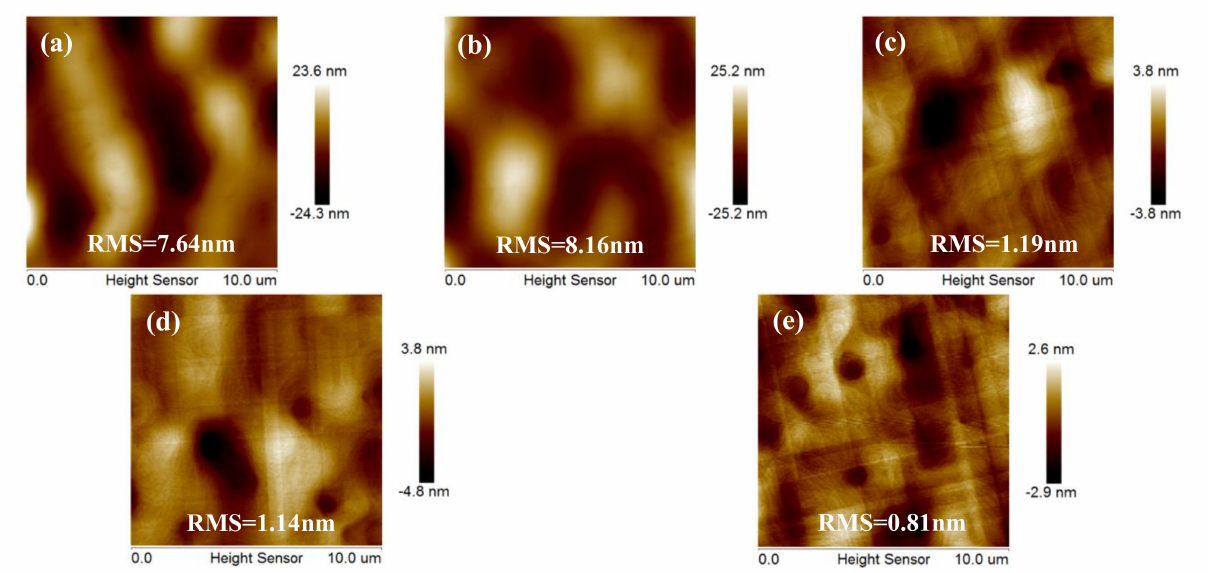
10 µ m 2 AFM images of 1000 nm high temperature (HT) Ge layers grown on ( a ) 25, ( b ) 50, ( c ) 100, Figure 6. 10 × ( d ) 200, and ( e ) 400 nm-thick of low temperature (LT) Ge buffer layers. The RMS of samples were 7.64, 8.16, 1.19, 1.14, and 0.81 nm,